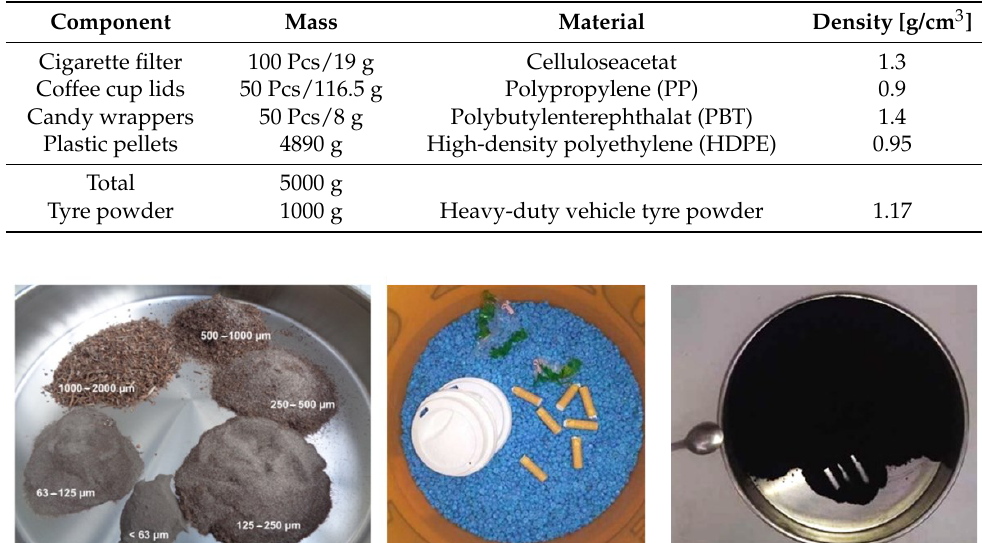
Table 7. Defined test substance/littering.